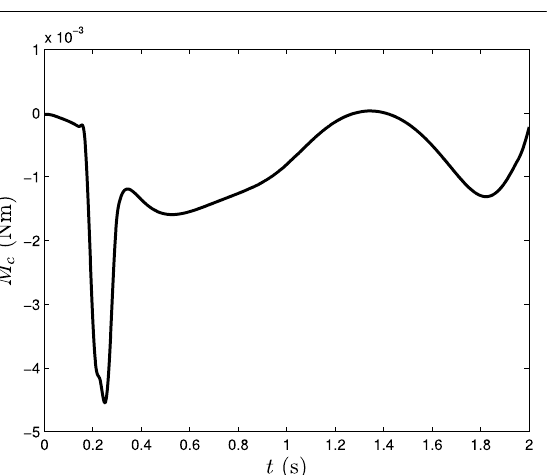
Fig. 12 Frictional moment at the contact interface of the soft tip and